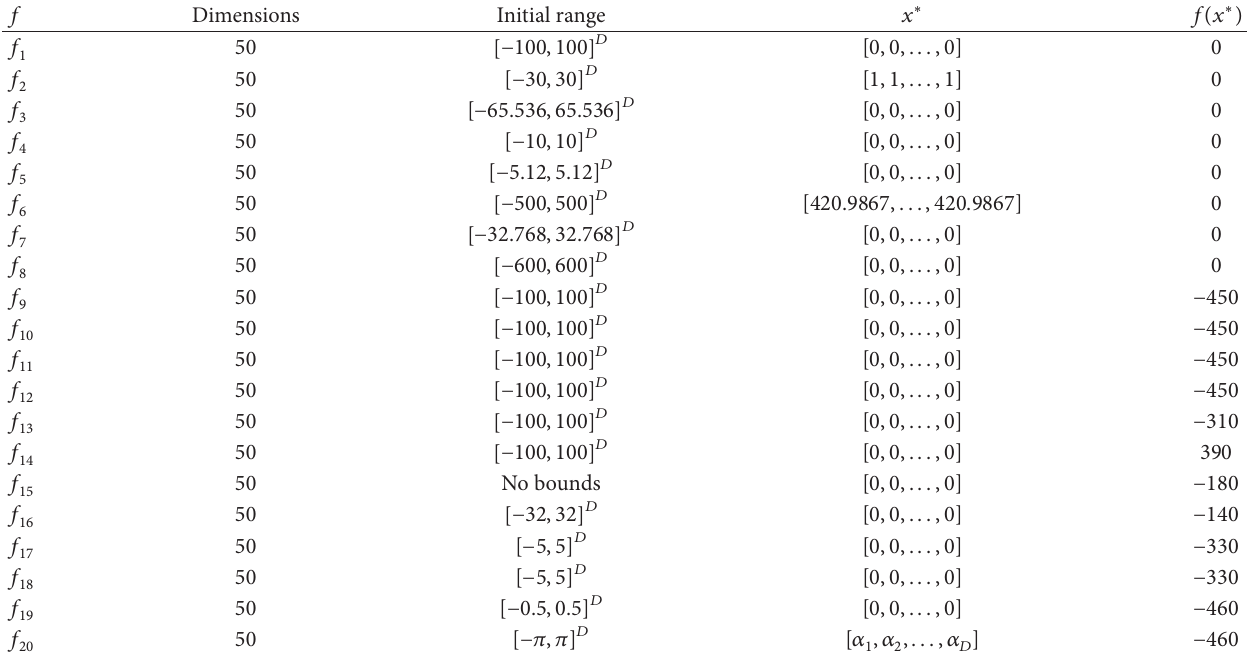
Table 11: Parameters of the test